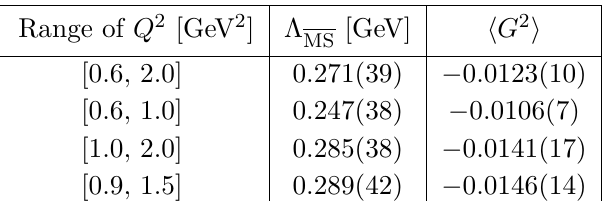
Table 1 . Results of the fit as we vary the range of the matching of D OPE ( Q 2 ) and D pheno ( Q 2 ) . The errors correspond to the change of scale by a factor of 2 or 1/2 from µ =